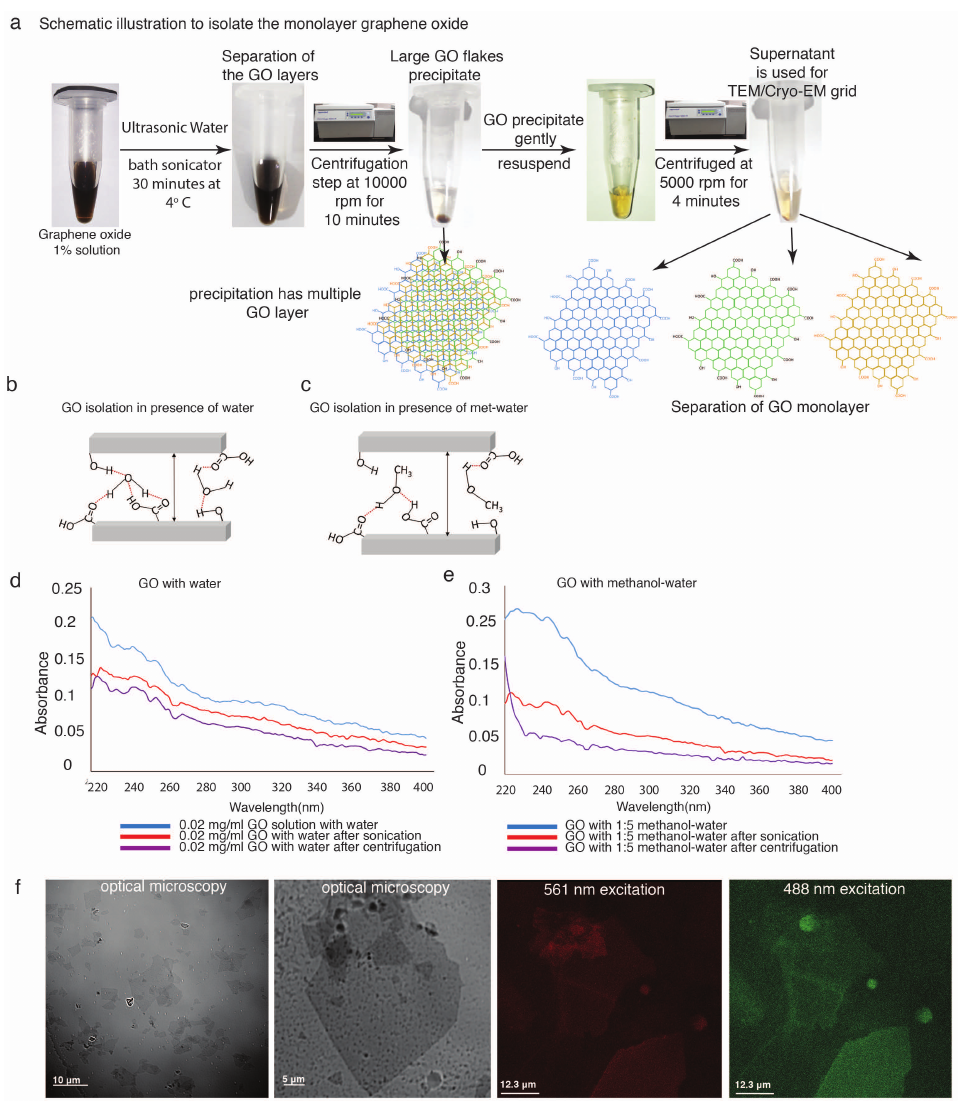
Figure 1. Exfoliation of single layered Graphene Oxide sheets: ( a ) Schematic representation of the workflow for producing Graphene Oxide (GO) monolayer. 1% GO solution is sonicated for 30 min before subjecting it to two rounds of centrifugation. Initial high speed centrifugation at 10,000 rpm to separate and remove the small GO flakes from the solution. The pellet containing multiple layers is gently resuspended and subjected to a 5000 rpm short spin. The supernatant obtained is then used to coat the EM grids. ( b , c ) Diagrammatic representation of H-bonding between GO layers and the ambient solvent-water ( b ) and methanol-water ( c ). ( d , e ) UV absorption spectra of GO monitored between 220 to 400 nm during the exfoliation process in both the solvent conditions. Red curve shows a distinct fall in A 230 of GO methanol/water due to segregation of the different populations of GO layers ( e ). ( f ) Suspension of GO in 1:5 methanol-water following centrifugation, is observed with optical and confocal microscopy. GO autofluorescence detected after series of laser excitation at 561 nm, 488 nm, illustrates the presence of large flakes in the size range of 10 µ m–70 µ